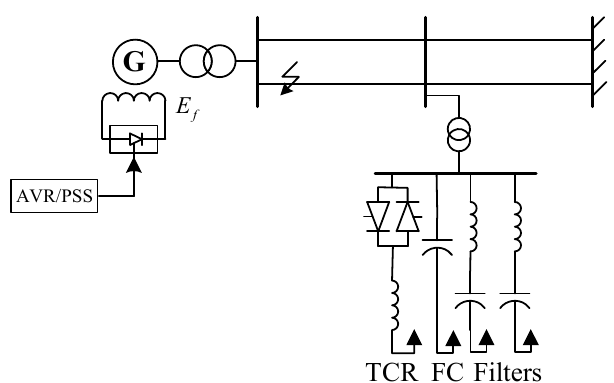
Figure 1. Simplified generator and static var compensator (SVC) three-bus model. AVR/PSS, automatic voltage regulator and power system stabilizer; TCR, thyristor controlled reactor; FC, fixed capacitor.